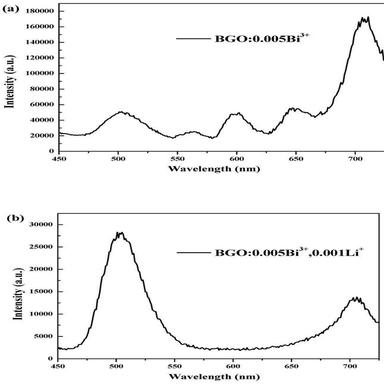
Afterglow spectra of BGO:0.005Bi3+ (a) and BGO:0.005 Bi3+, 0.001Li+ (b) after 5-min excitation with 254 nm UV lamp.